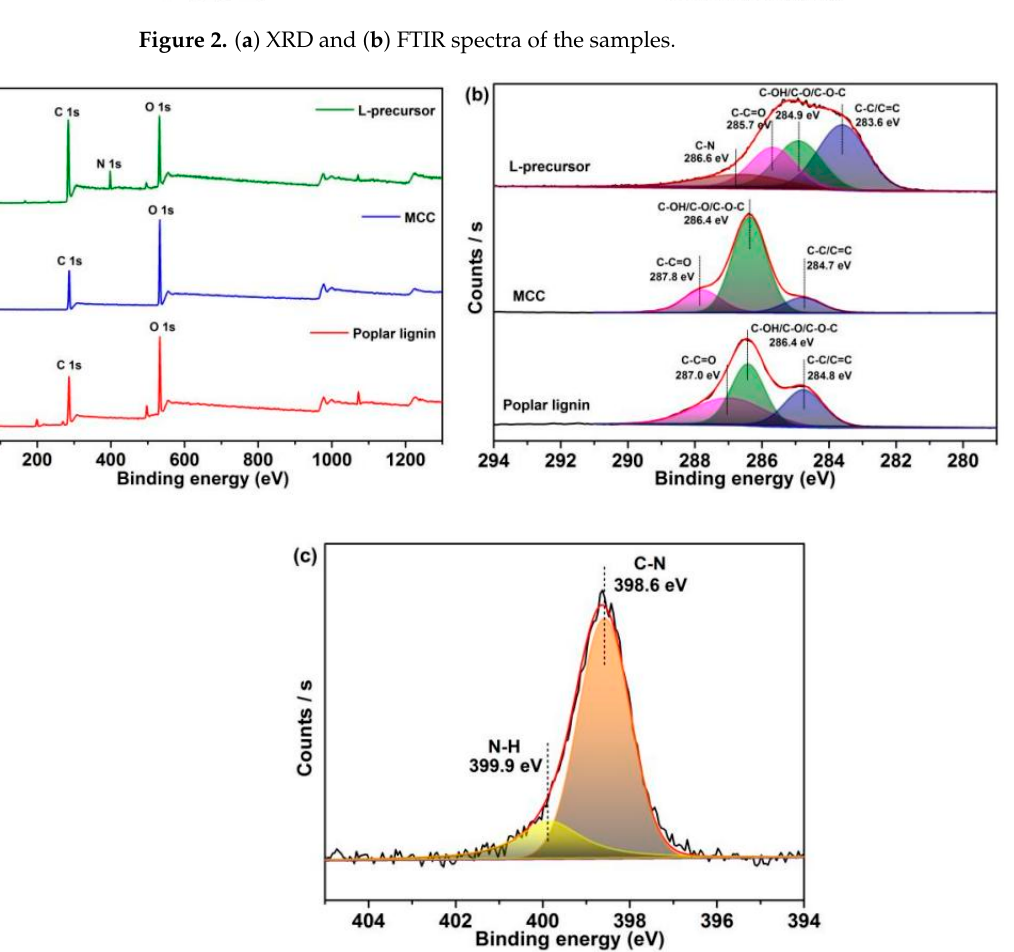
Figure 3. ( a ) XPS survey spectra of the samples. High-resolution XPS ( b ) C 1s spectrum and ( c ) N 1s spectrum of the